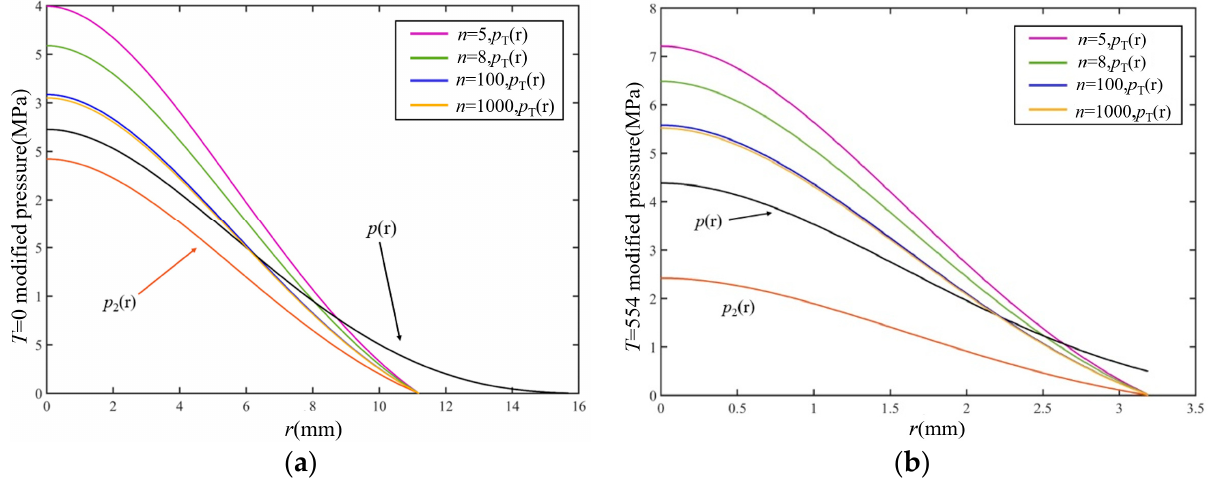
Figure 9. High-order discrete contact pressure correction curves: ( a ) T = 0 N; ( b ) T = 554